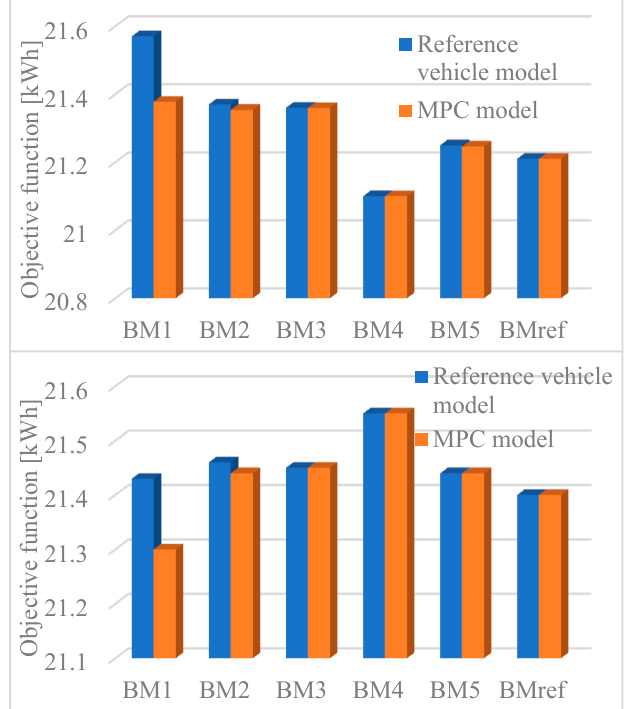
Figure 13. Objective function comparison at the end of the two UDDS ( up ) and HWFET ( down ) drive cycles.